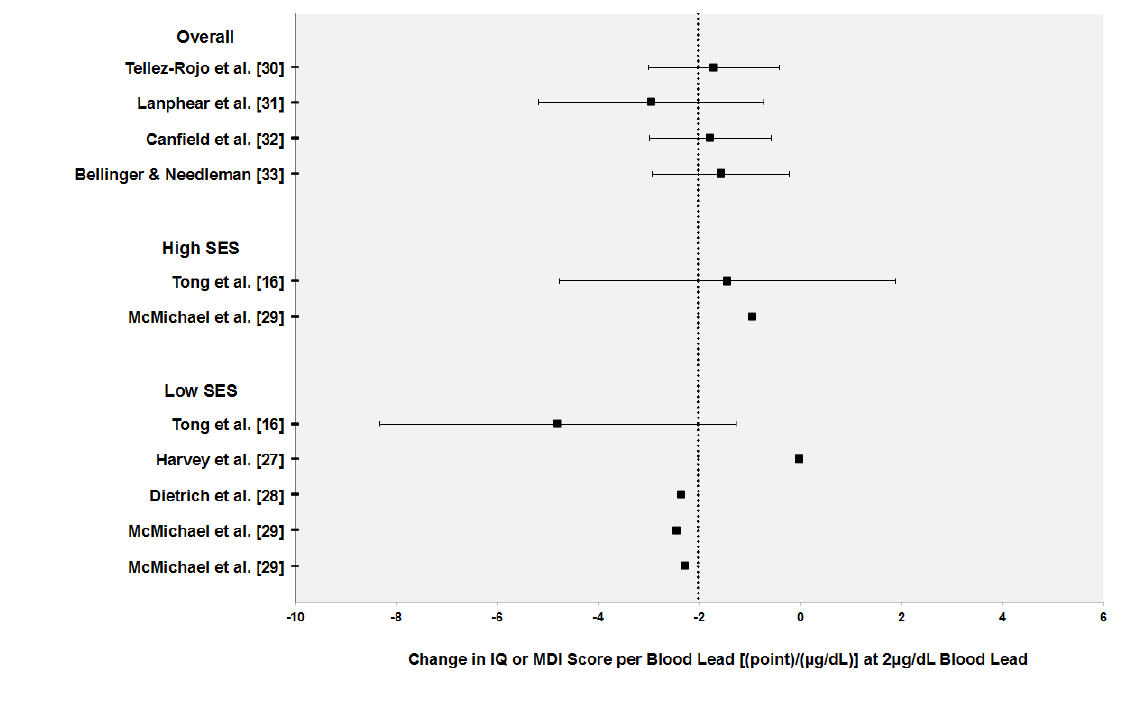
Figure 1. Concentration-response (CR) functions for neurocognitive outcomes in children (intelligence quotient and mental development index) grouped according to socioeconomic status. CR functions are calculated at 2 µg/dL blood lead level. Error bars represent 95% confidence intervals. Vertical dotted line represents mean CR estimates across